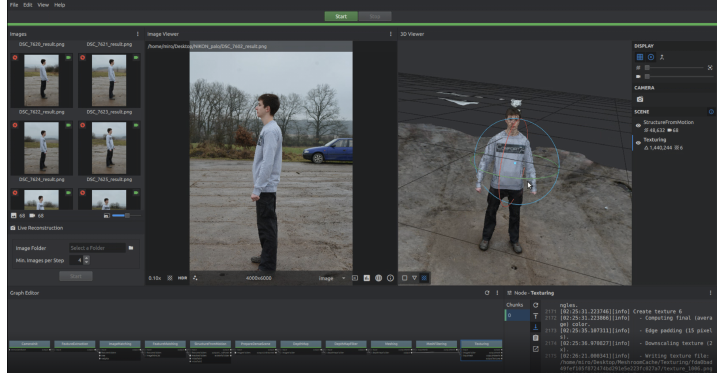
Figure 3. Meshroom–human model meshing.